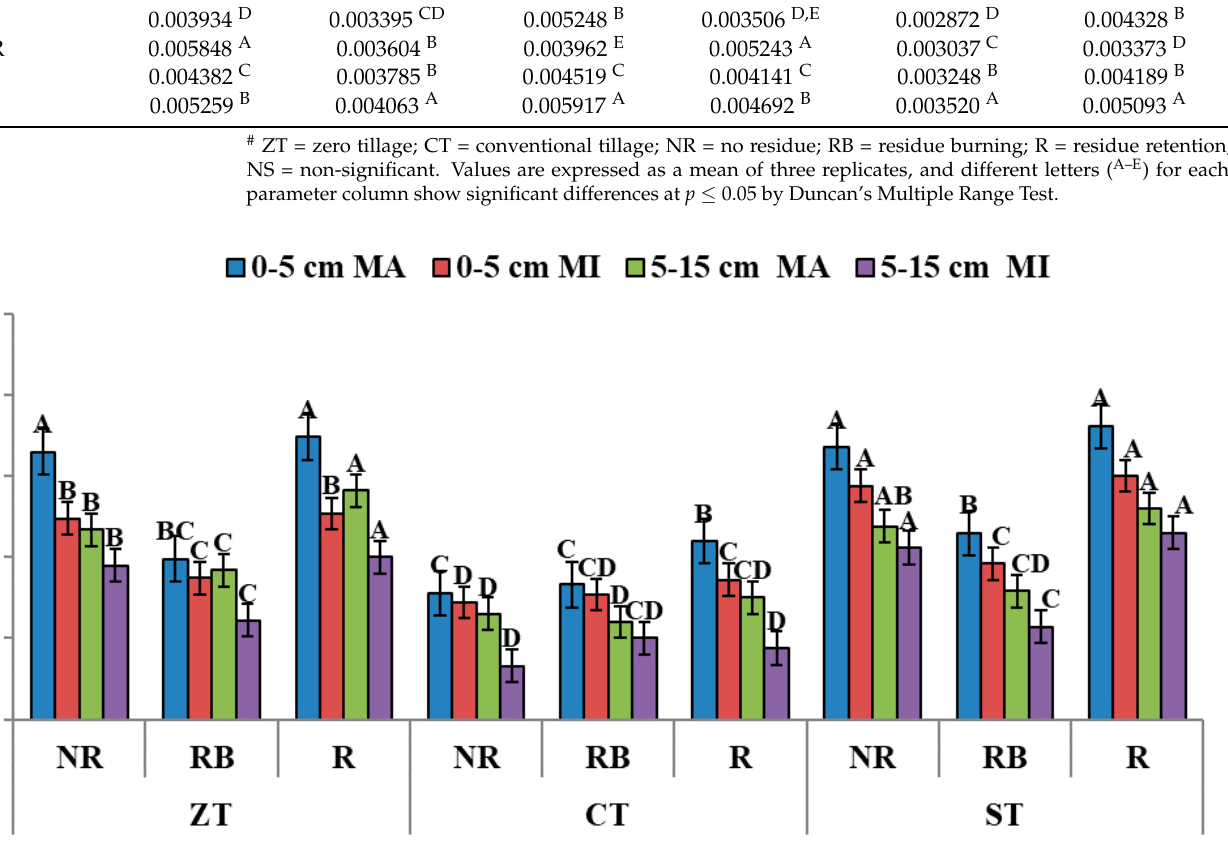
Figure 7. Glomalin content (mg g − 1 ) of macro- and micro-aggregates in different depths as affected by 18 years of tillage and residue management in a rice–wheat cropping system in an Inceptisol. Different letters (A–D) for each parameter column show significant differences at p ≤ 0.05 by Duncan’s Multiple Range Test. ZT = zero tillage; CT = conventional tillage; ST = strip tillage; NR = no residue; RB = residue burning; R = residue retention; MA = Macro-aggregate; MI = Micro-aggregate. LSD value in 0–5 cm for MA: T: 0.16, RM: 0.15, T × RM: 0.25; for MI: T: 0.20, RM: 0.11, T × RM: 0.22; In 5–15 cm soil layer for MA: T: 0.14, RM: 0.13, T × RM: 0.22; for MI: T: 0.20, RM: 0.07, T × RM: